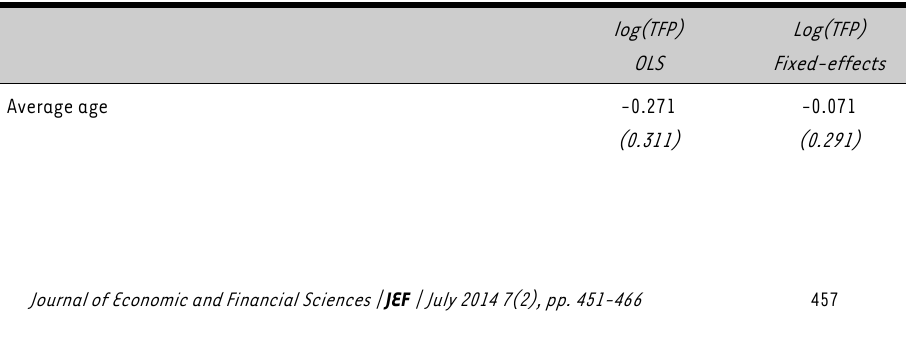
TABLE 1: Firm-based employee diversity productivity